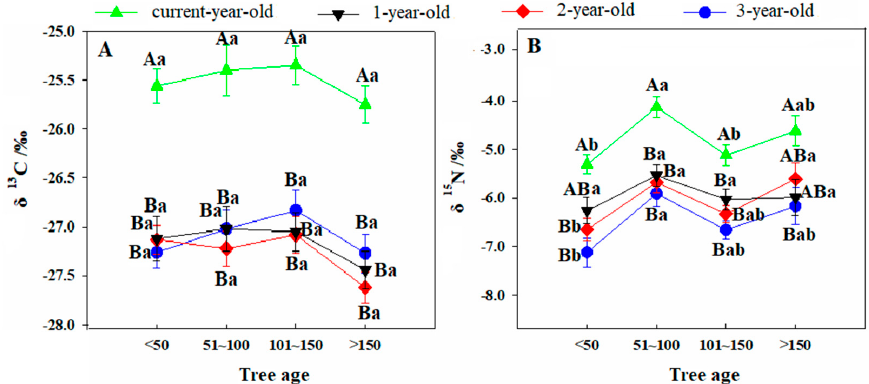
Figure 3. Differences in leaf δ 13 C ( A ) and δ 15 N ( B ) between 4 years’ leaves collected along different tree age levels. The value was Mean± SE (standard error). Different uppercase letters represent significant differences among leaf ages at each tree age level, while different lowercase letters represent significant differences among tree ages at each leaf age level.